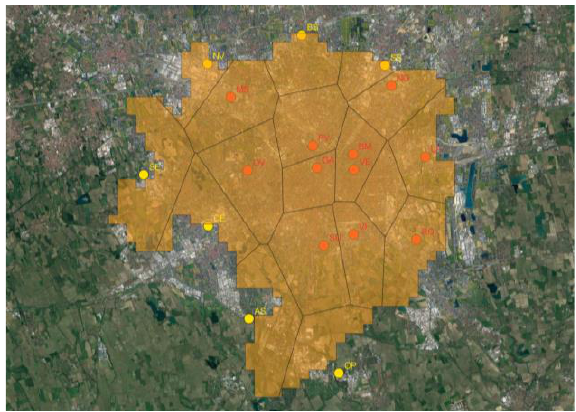
Figure 18. Current PS service areas.